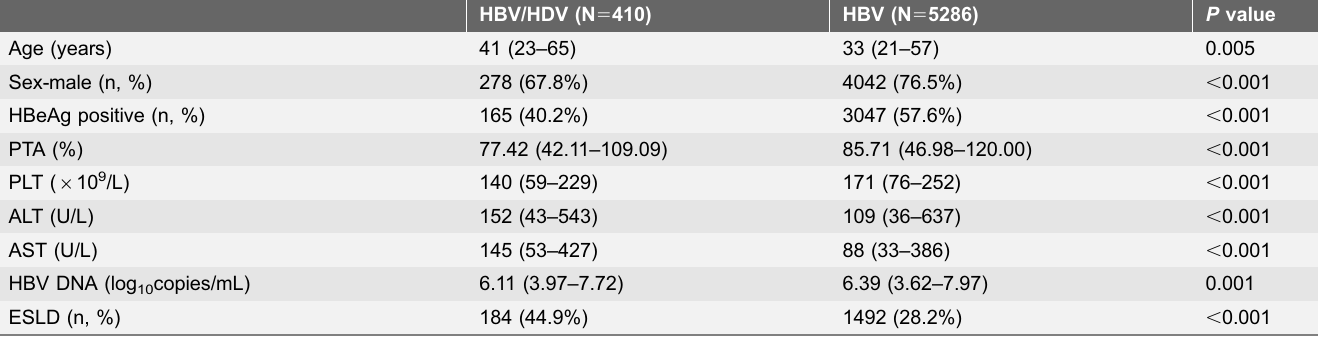
Table 1. Demographic and clinical characteristics of HBV/HDV co-infected patients.